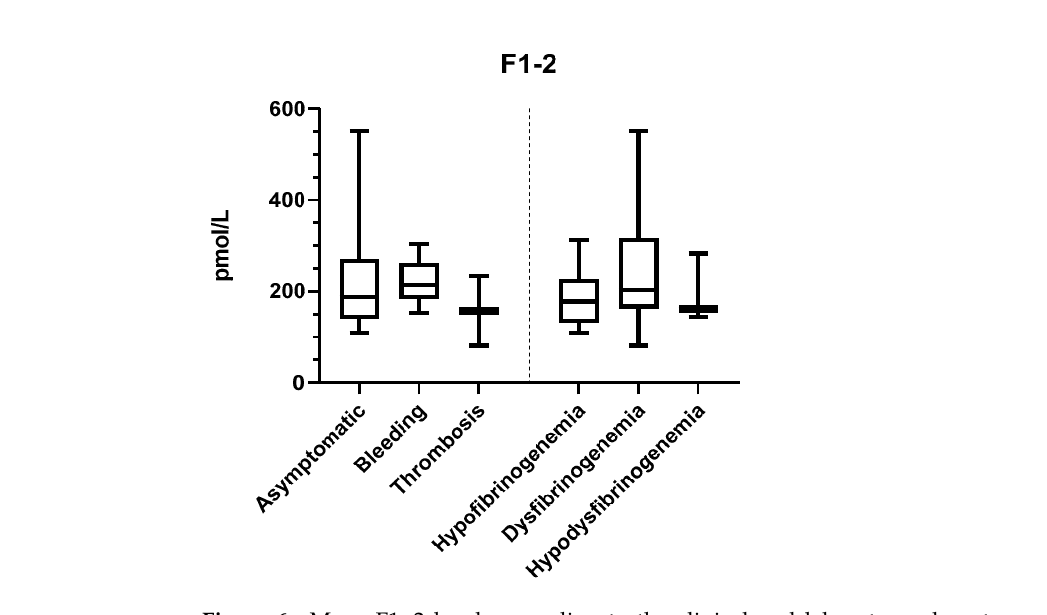
Figure 6. Mean F1+2 levels according to the clinical and laboratory phenotypes. F1+2 values are shown for 20 patients as follows: asymptomatic n = 13; bleeding n = 5, thrombosis n = 2; hypofibrinogenemia n = 9; dysfibrinogenemia n = 8; and hypodysfibrinogenemia n = 3.